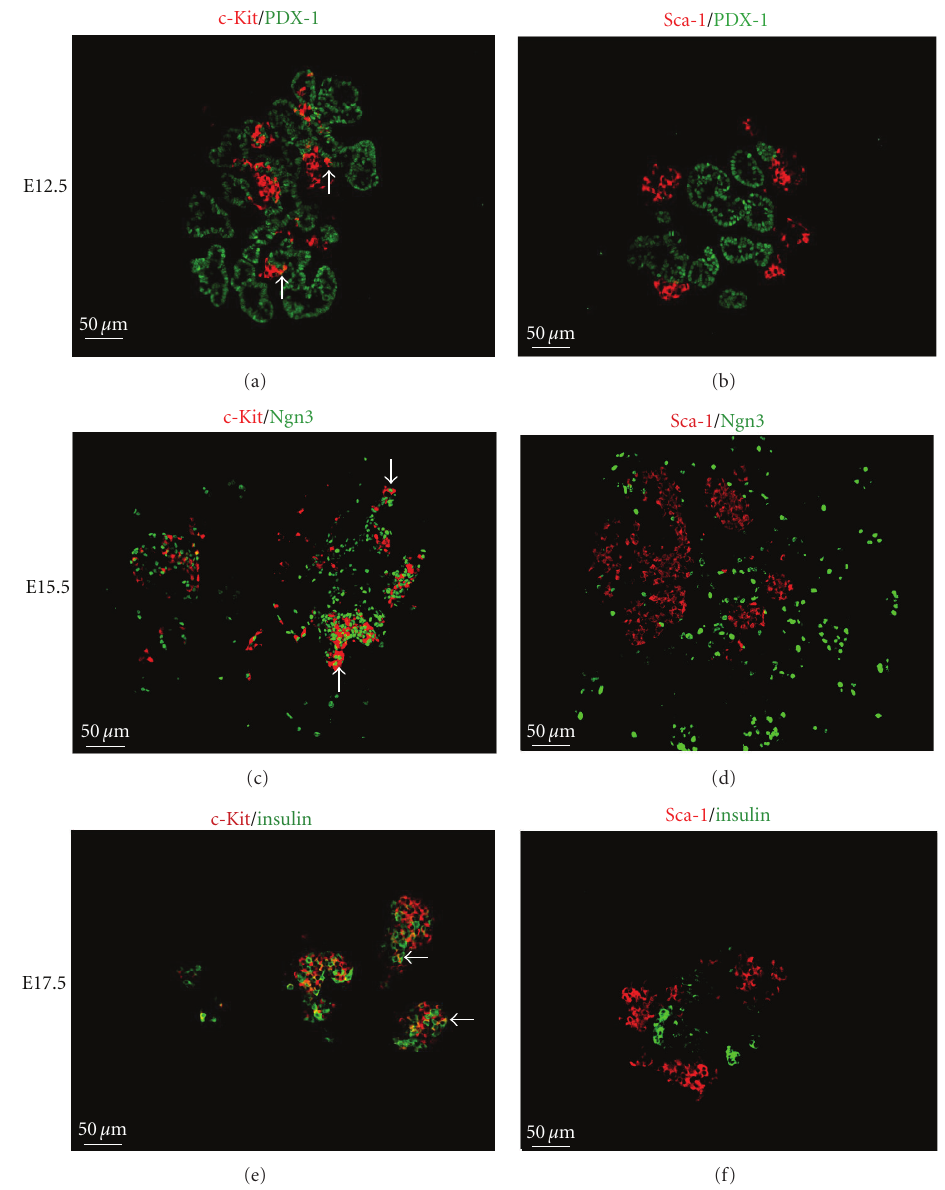
Figure 2: The coexpression of Sca-1 and c-Kit with PDX-1, Ngn3, and insulin in embryonic pancreas at E12.5, E15.5, and E17.5 by immuno- histochemistry. White arrow marked c-Kit-positive cells coexpressed with PDX-1, Ngn3, and